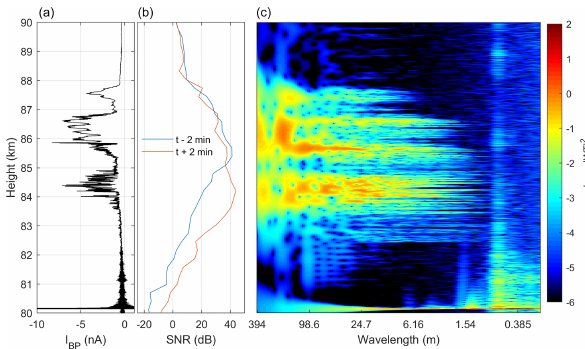
Figure 13. Comparison of DUSTY-1B bottom plate current (a) , MAARSY 53.5MHZ radar SNR along the rocket trajectory (b) , and PSD from wavelet transform (c) – for the MXD-1B launch. The spatial scales in the right panel were converted from frequency to approximate wavelength through λ = 2 πv R /ω , where the rocket velocity was set to that of the middle of the dust cloud; v R = 800ms − 1 . Radar data courtesy of Ralph Latteck, IAP Kühlungs-